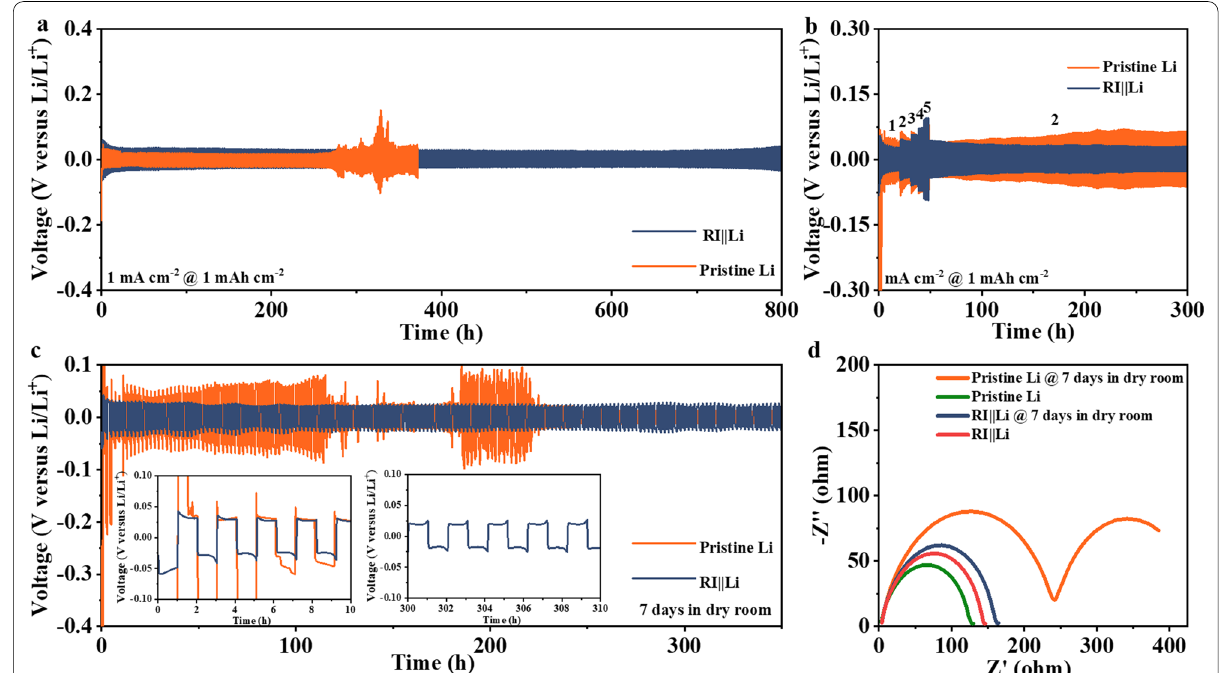
Fig. 2 Galvanostatic Li plating/stripping voltage profiles for the RI||Li and pristine Li symmetric cells at a capacity of 1 mAh cm − 2 with a current density of a 1 mAh cm − 2 and b various current densities. c Galvanostatic Li plating/stripping voltage profiles for the RI||Li and pristine Li symmetric cells at a capacity of 1 mAh cm − 2 with a current density of 1 mAh cm − 2 after stationary in the dry room for 7 days. d , EIS results before and after